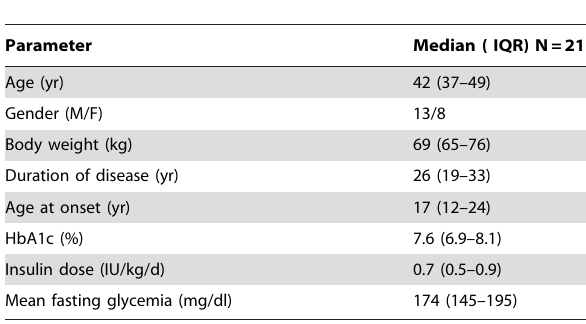
Table 1. Recipient